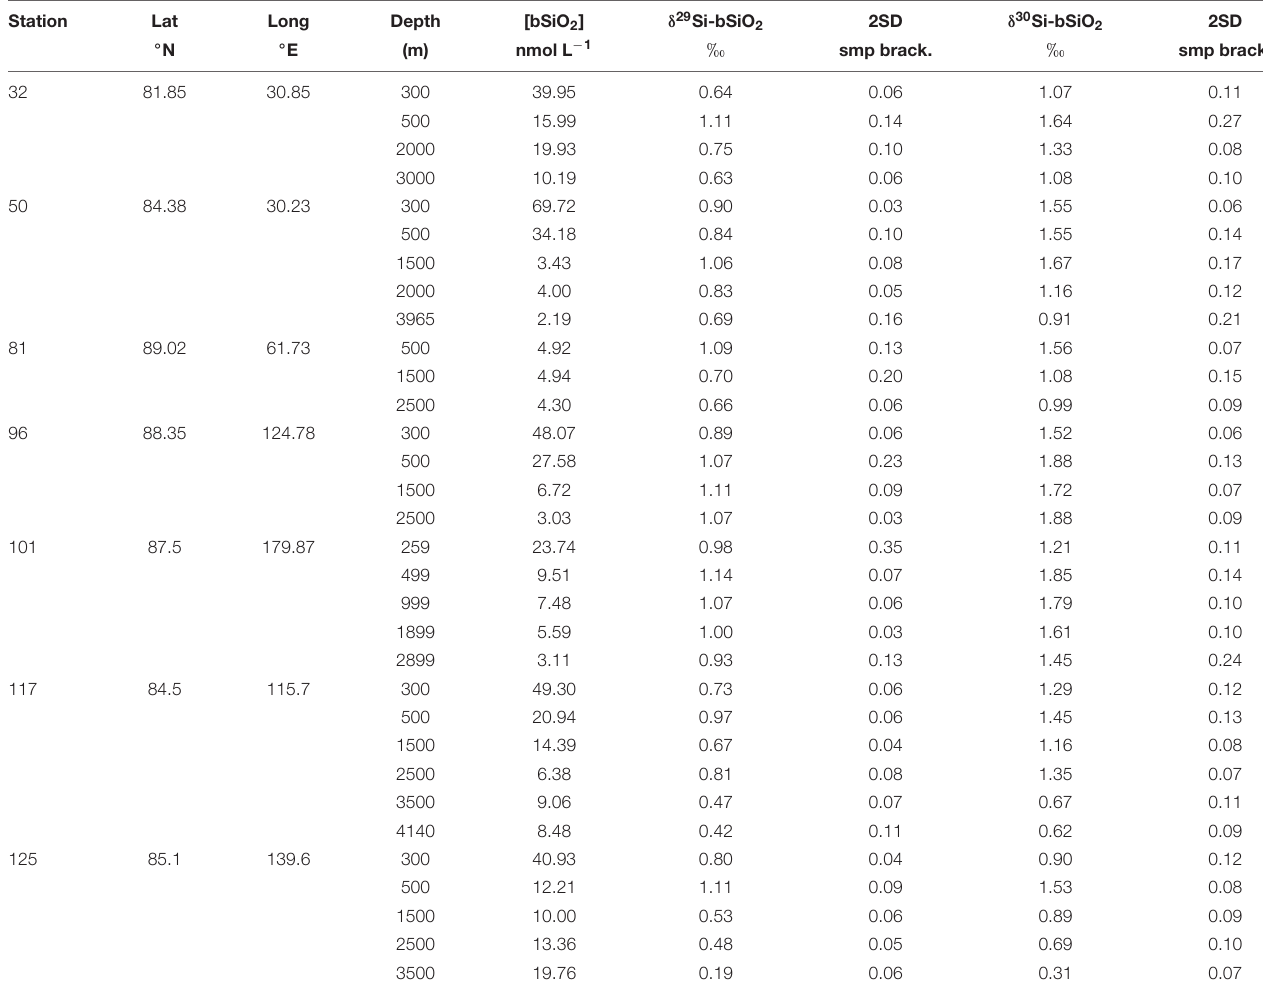
TABLE 3 | Biogenic Silica concentrations and δ 30 Si-bSiO 2 .